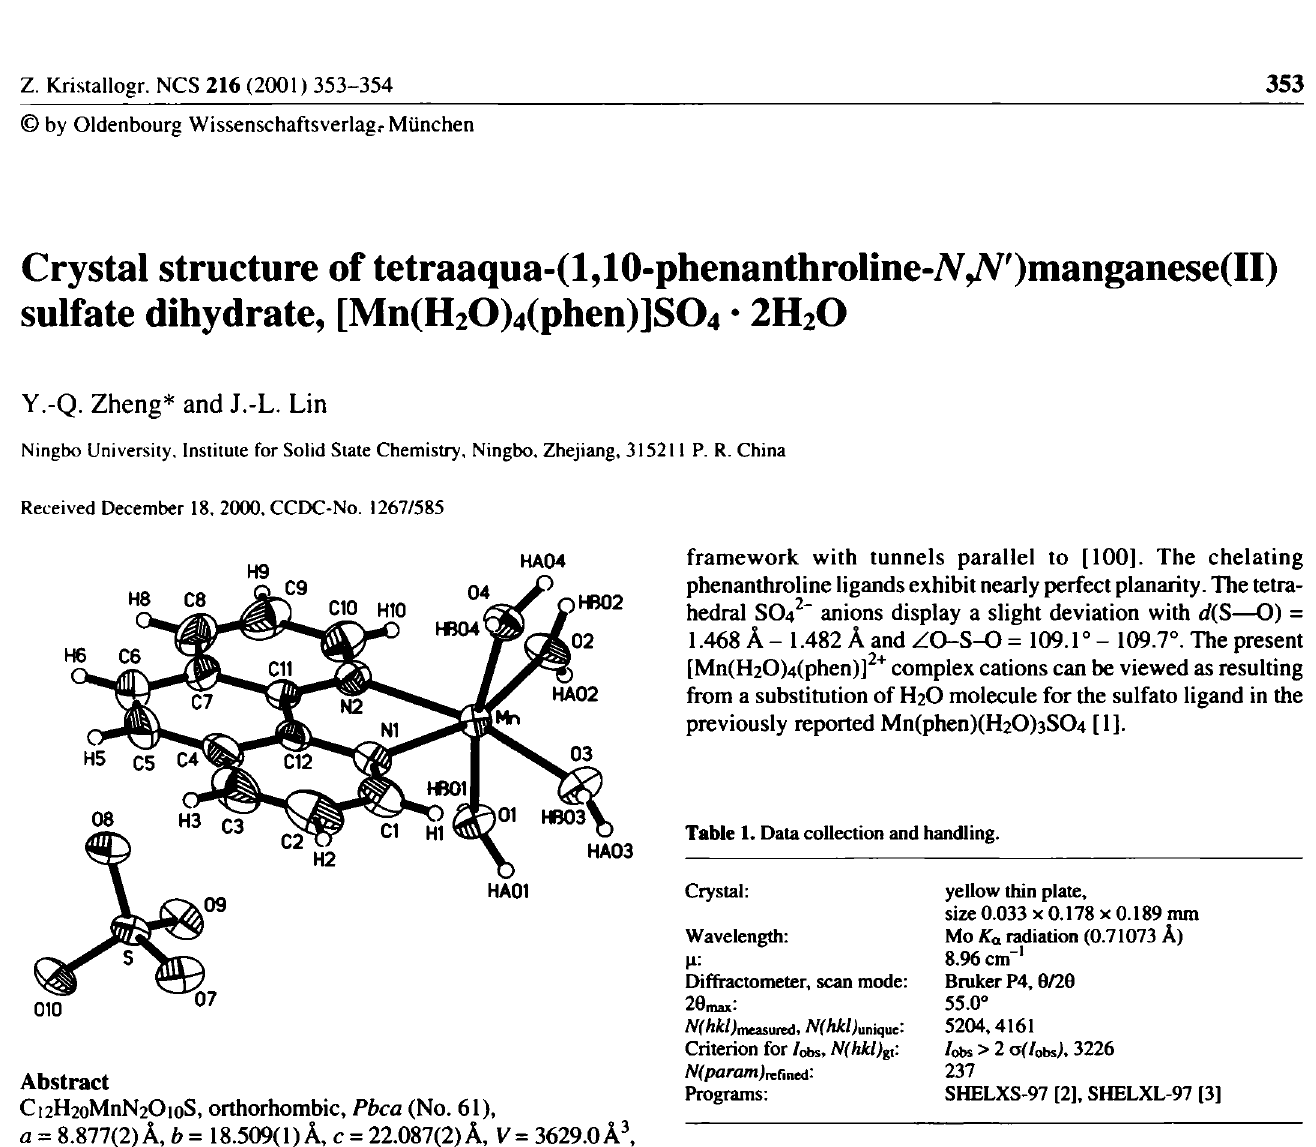
Table 2. Atomic coordinates and displacement parameters (in A 2